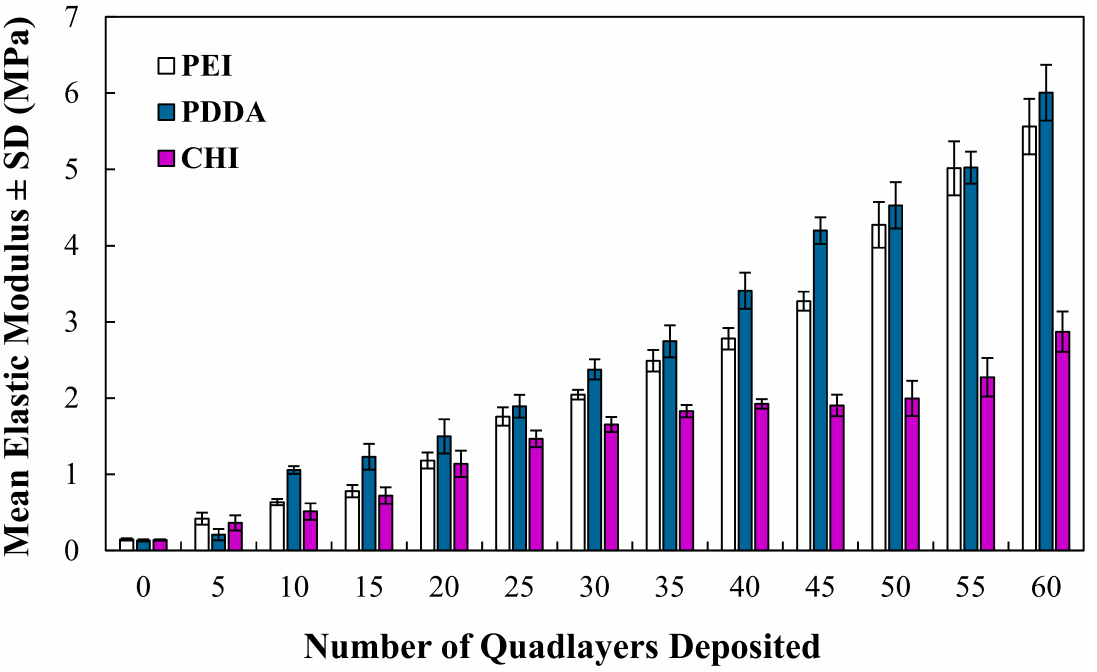
Figure 4. Mean elastic modulus ± SD of the coated foams as a function of the quad layers